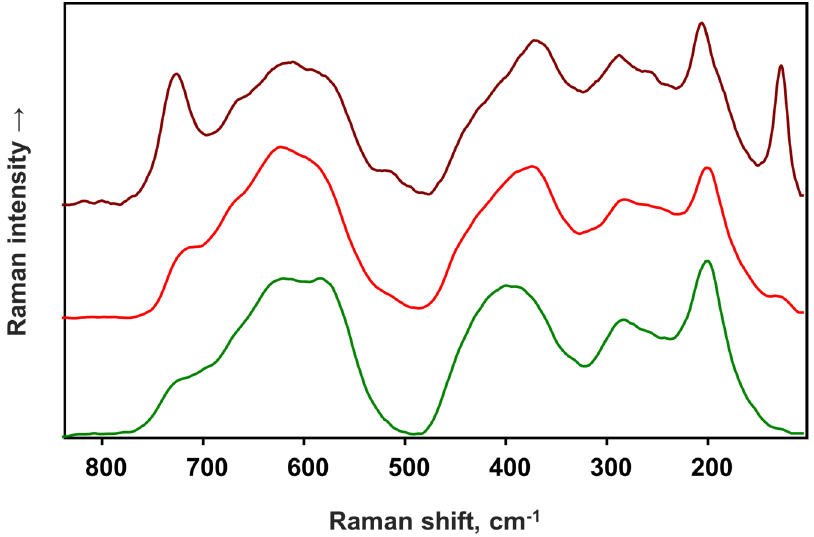
Figure 4. Raman spectra of MXene film with 532 nm (bottom), 633 nm (middle) and 785 nm (top) excitation.